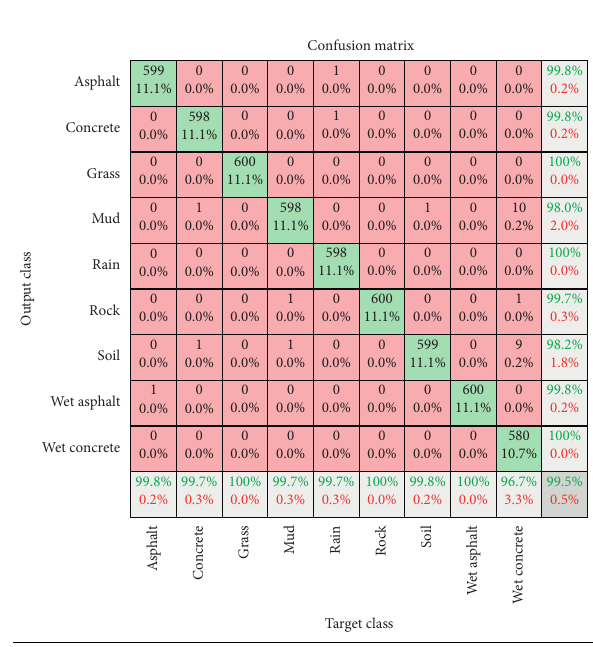
Table 3: The classification results of test samples based on